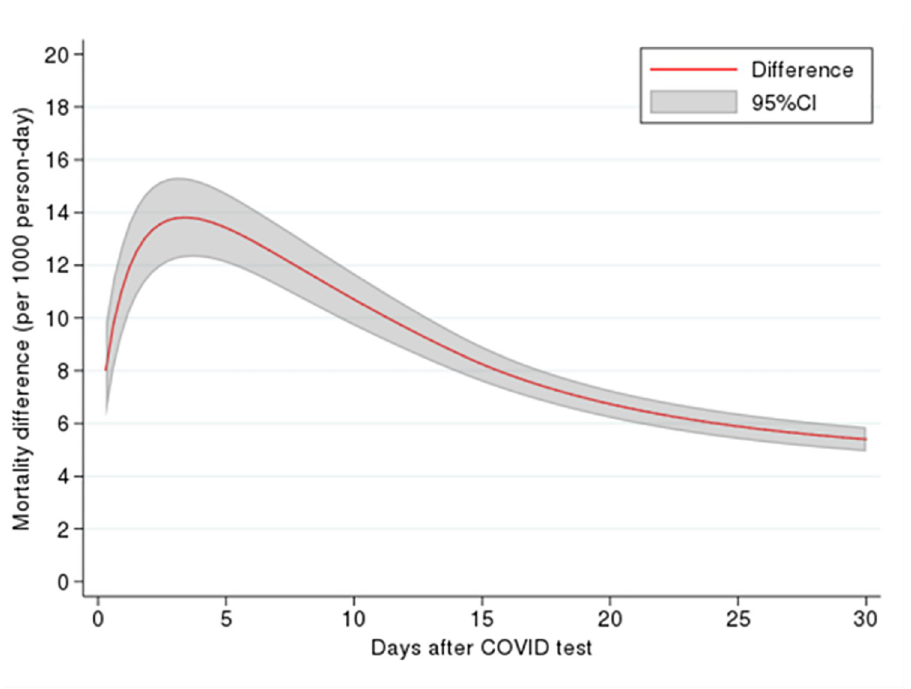
Fig 3. Excess mortality rate due to a positive COVID-19 test, adjusted for sex, age group, Changes in Health, End- stage disease and Symptoms and Signs (CHESS) scale, frailty, and long-term care home ownership.